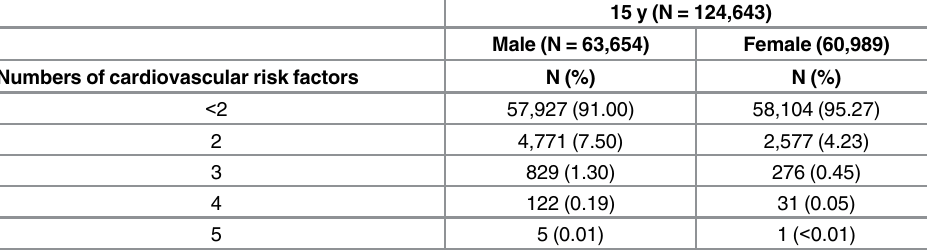
Table 2. Numbers of participants having cardiovascular risk